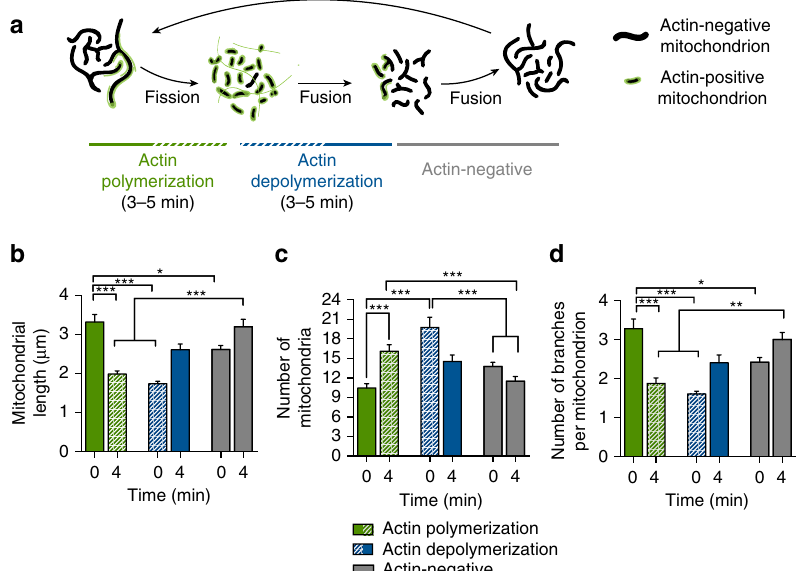
Figure 8 | Actin cycling through mitochondrial subpopulations regulates steady-state mitochondrial morphology. ( a ) Model: actin polymerizes on a subpopulation of elongated mitochondria, inducing robust fragmentation. After B 3–5min, actin then depolymerizes, allowing the fragmented mitochondria to refuse and slowly increase in size and complexity. Actin-negative mitochondria slowly continue to grow until they become locally hyperfused, at which point actin is recruited and the cycle repeats. ( b ) Mitochondrial size decreases with actin recruitment and recovers on subsequent actin depolymerization. ( c ) Actin polymerization induces rapid mitochondrial fission, whereas depolymerization promotes slow fusion. ( d ) Mitochondrial complexity decreases with actin recruitment and recovers on actin depolymerization. Values represent mean ± s.e.m. *** P o 0.001, ** P o 0.01 and * P o 0.05. Sample size: ( b – d